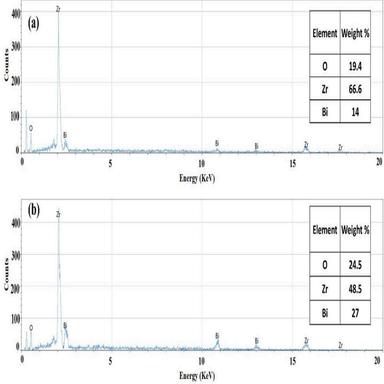
EDX and elemental composition analysis of BZO composite: (a) BZO-1 and (b) BZO-2.